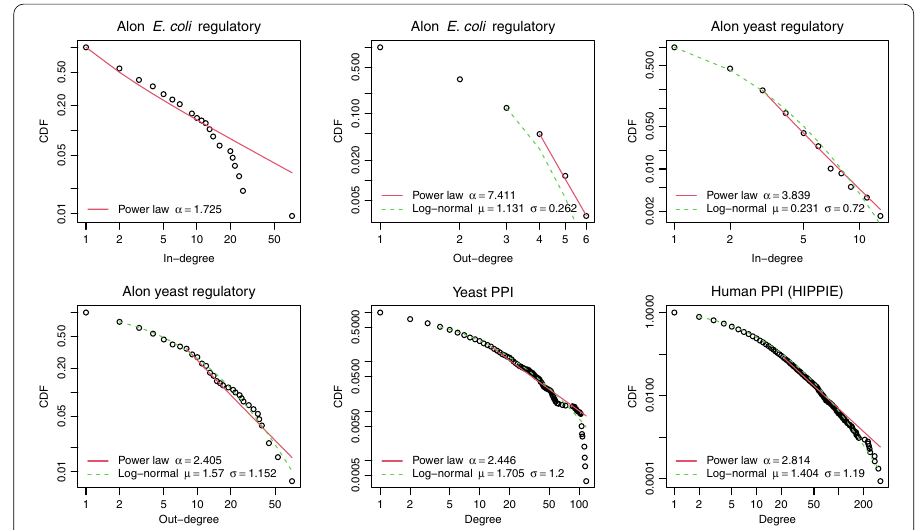
Fig. 3 Degree distributions of the networks. Power law and log-normal distributions fitted to the CDF for degree distributions of the networks (in- and out-degree for directed networks, degree for undirected networks). All distributions apart from the E. coli in-degree distribution (for which a log-normal distribution could not be fitted), and the Human PPI (HIPPIE) degree distribution (which is not consistent with a power law distribution, p < 0.01 ), are consistent with both power law and log-normal